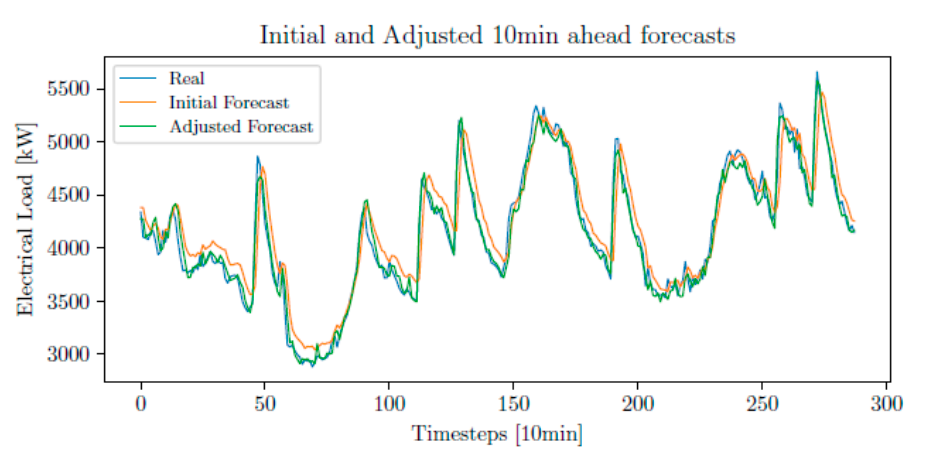
Figure 20. Ten-minutes-ahead adjusted forecasts.